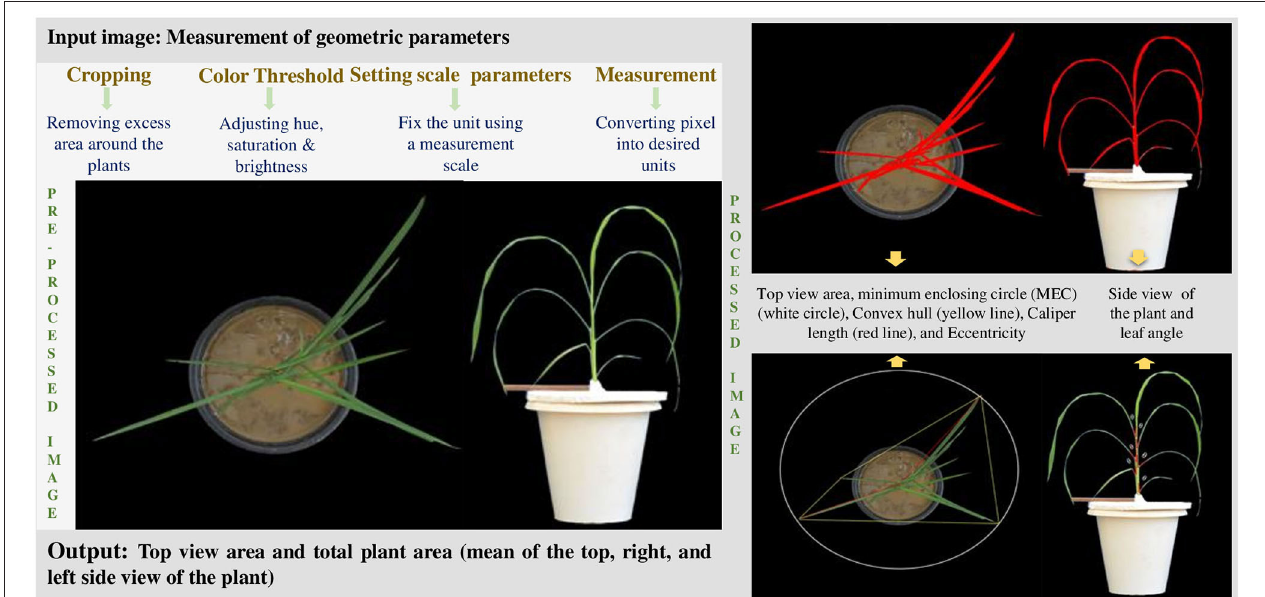
FIGURE 1 | Image processing and derivation of geometric parameters with representative plant image.